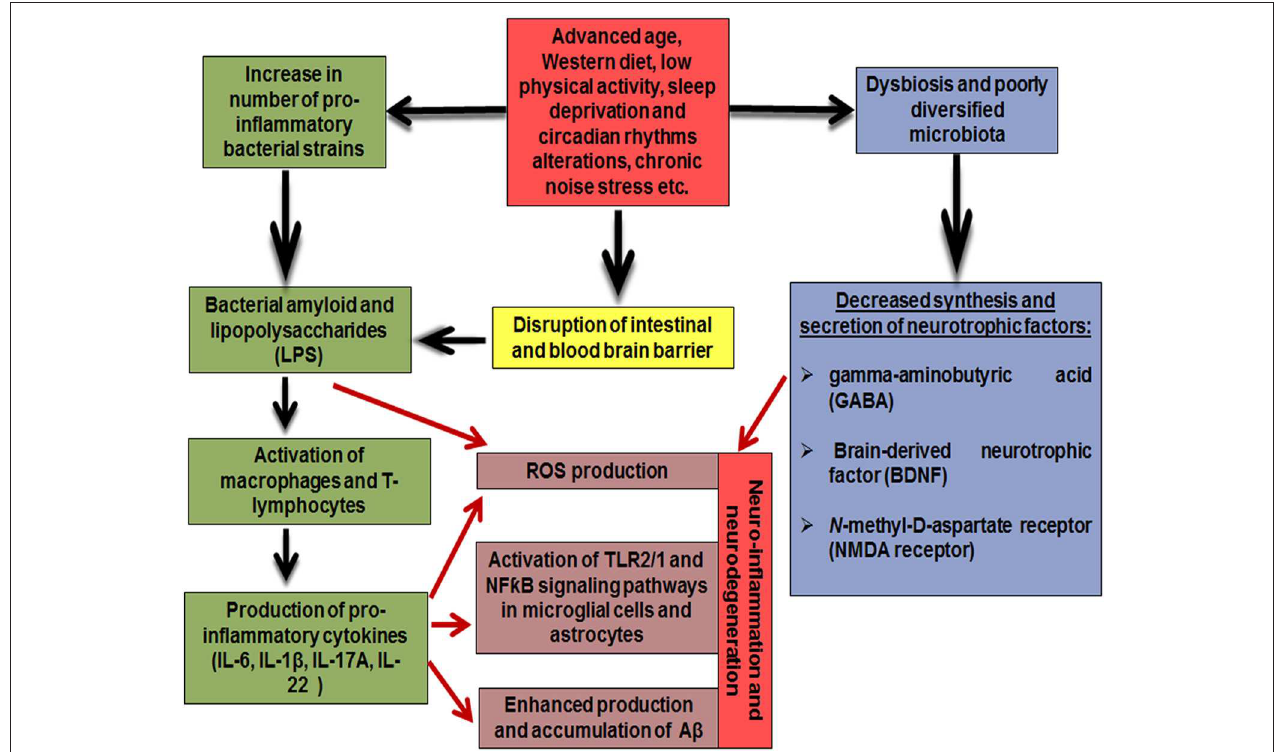
FIGURE 1 | Mechanisms underlying the effect of gut microbiome on the pathogenesis of Alzheimer’s